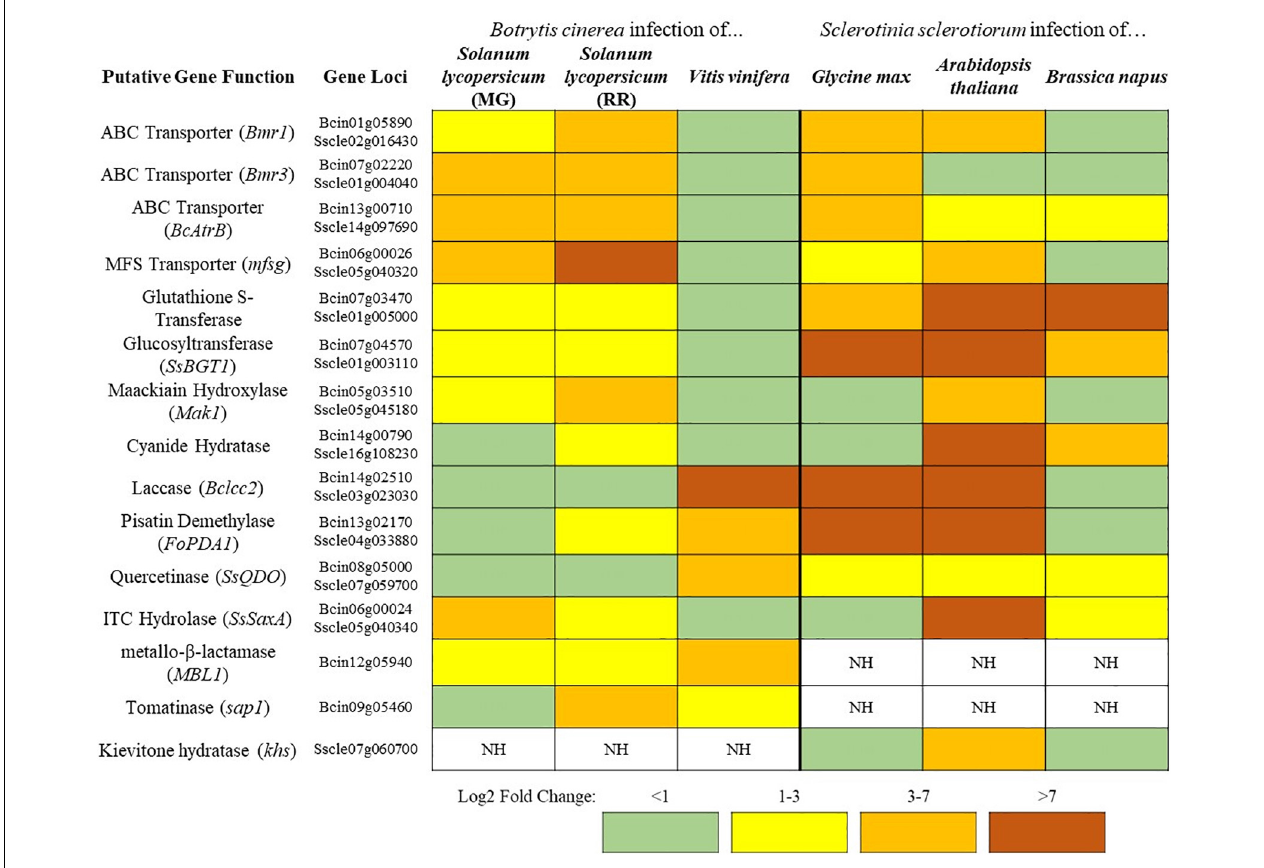
FIGURE 1 | A sampling of Botrytis cinerea and Sclerotinia sclerotiorum genes putatively involved in detoxification of PDCs. Simplified differential gene expression values are presented for B. cinerea [infecting mature green (MG) and red ripe (RR) Solanum lycopersicum and Vitis vinifera ] and S. sclerotiorum (infecting Glycine max, Arabidopsis thaliana , and Brassica napus ) (Haile et al., 2017; Seifbarghi et al., 2017; Petrasch et al., 2019; Peyraud et al., 2019; Westrick et al., 2019). All samples were harvested at ∼ 24 h post inoculation and differential expression values were generated through comparison to in vitro culture controls. NH = no homolog found in the